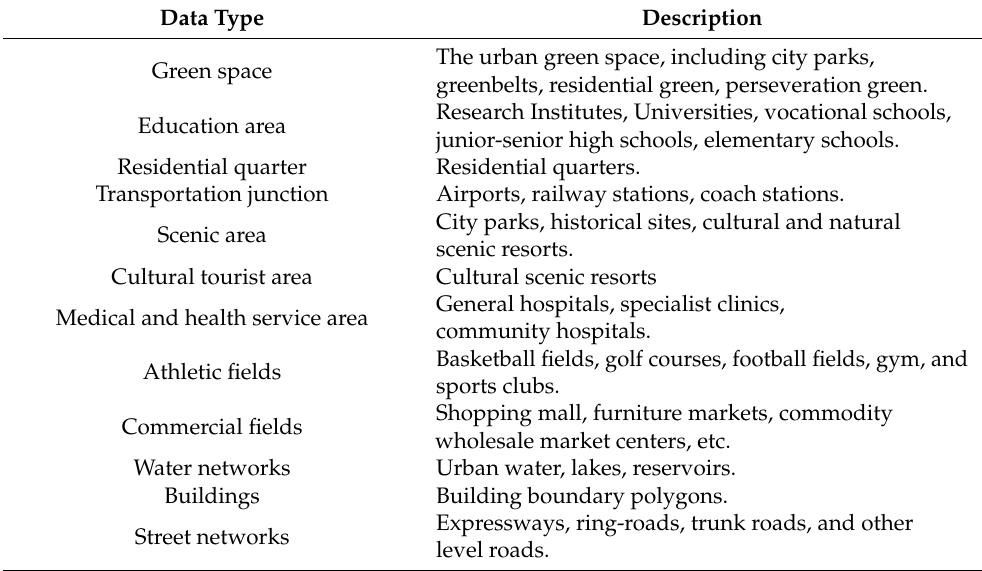
Table 1. The data crawl by the online map data crawl systems ( OMDCS